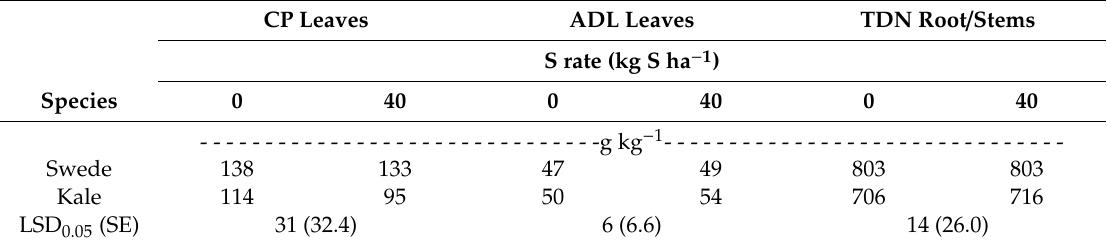
Table 8. Crude protein and ADL for leaves and TDN for root / stems of swede and kale with five nitrogen (N) rates and two sulfur (S) rates across three environments at Prosper and Walcott, ND, USA, in 2012 and 2014. CP Leaves ADL Leaves TDN Root / Stems S rate (kg S ha − 1 ) Species